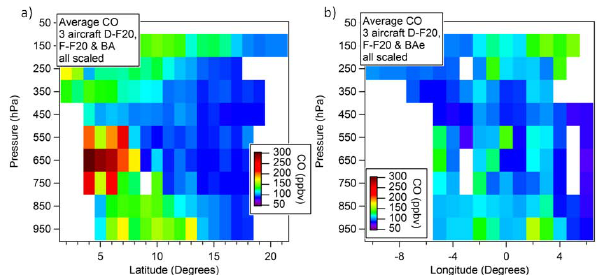
Fig. 4. Average CO concentrations in bins of 100hPa of atmo- spheric pressure and (a) 1 degree of latitude and (b) 1 degree of longitude based on 1-minute data from the BAe-146, DLR Falcon and French Falcon between 20 July and 21 August. Note that the concentrations have been scaled according to the comparisons of